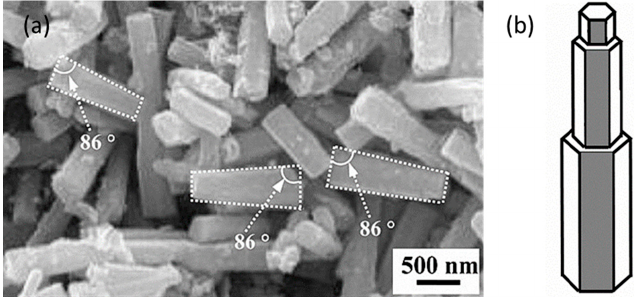
Figure 2. Scaning electron microscopy (SEM) morphology ( a ) and configuration profile ( b ) of ‘‘multi ‐ level tower’’. Reproduced with permission from [124]. Copyright Elsevier, 2011.